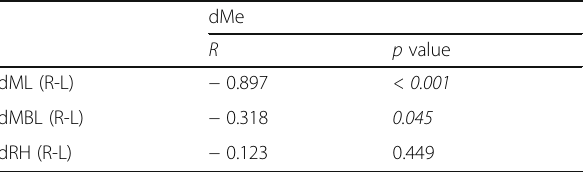
Table 6 The correlation between chin deviation and difference between the measurements of distances in paired lower facial third structures ( N = 40).